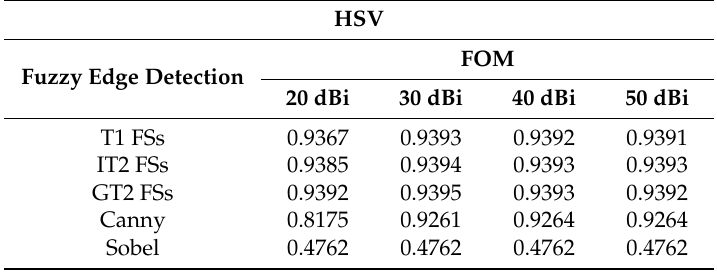
Table 11. T1, IT2, and GT2 FS edge detection applied on HSV color format images with Gaussian noise.